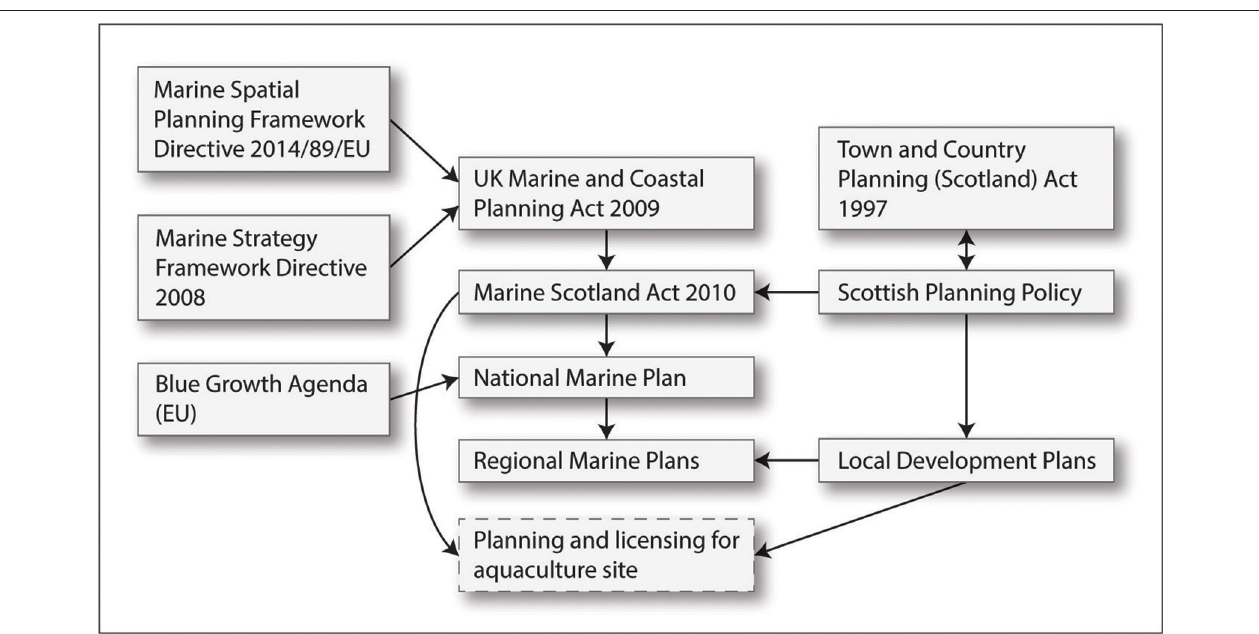
FIGURE 1 | Rough guide to the marine planning regime in Scotland as described by Brooker et al. (2019) in addition to Billing (2018). Dotted lines show processes that include local level stakeholder and community